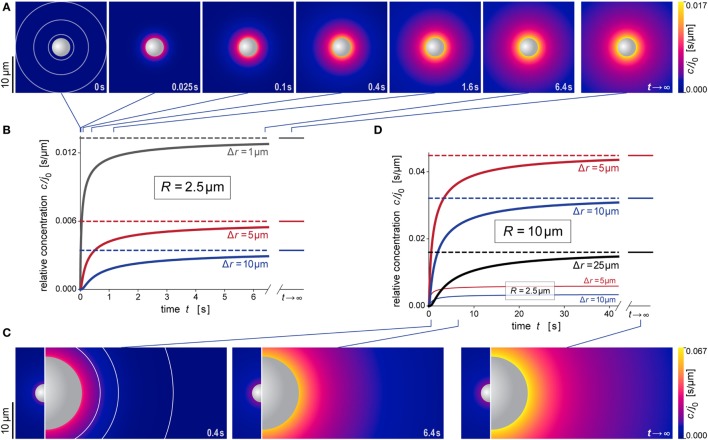
Predicted behavior during formation of the anaphylatoxic cloud. (A) Snapshots of our simulation of the evolution of the anaphylatoxic cloud around a spherical particle with radius R = 2.5 μm (see also Video S2 in Supplementary Material). The color gradient denotes the relative concentration c/j0. The concentric circles included in the first image indicate the distances from the source surface used for the plots in (B). (B) Relative concentration c/j0 as a function of time at three selected distances Δr for R = 2.5 μm. The time points corresponding to the density plots of (A) are indicated at the top. (C) Snapshots of our simulation of the evolution of the anaphylatoxic cloud around a spherical particle with radius R = 10 μm (see also Video S3 in Supplementary Material). The circle sections included in the first image indicate the distances from the source surface used for the plots in (D). For direct comparison, each of the three panels includes the result obtained for R = 2.5 μm at the same time point. Here, the color gradients of all density plots use the same, common color scale. (D) Relative concentration c/j0 as a function of time at three selected distances Δr for R = 10 μm. For direct comparison, two of the plots of (B) (obtained for R = 2.5 μm) are included as well. The time points corresponding to the density plots of (C) are indicated at the bottom. All concentrations were evaluated using the parameter values D = 130 μm2 s−1 and k = 1.1 × 10−2 s−1 typical for C5a.